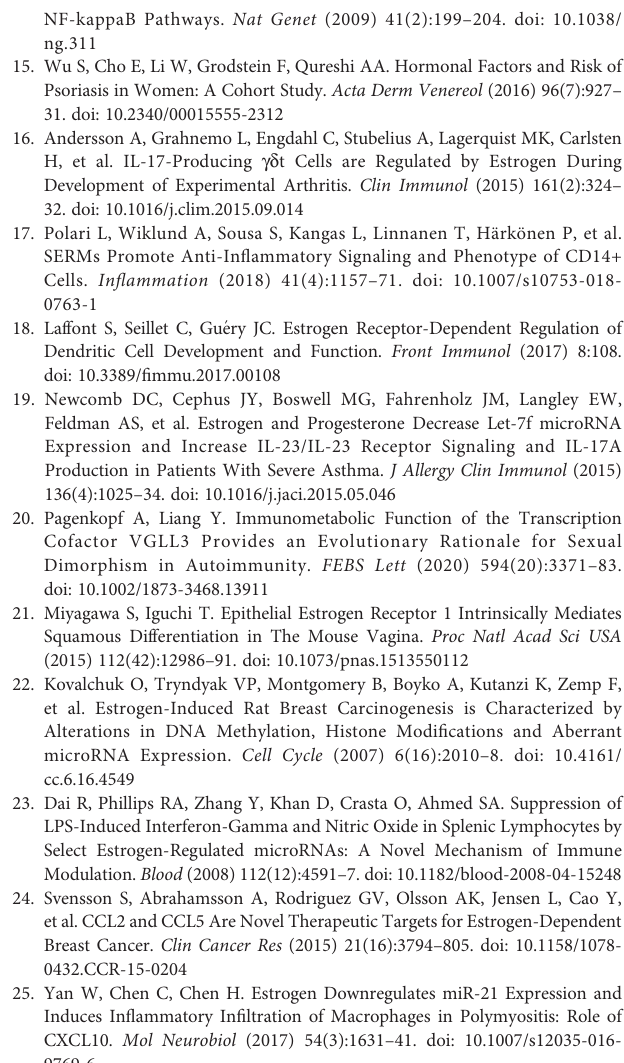
mannan (n = 5/group). Each experiment was repeated twice. Statistical analyses were performed using an unpaired t test. n indicates number of mice. The data represent mean ± SEM. * p < 0.05; ** p < 0.01. *** p < 0.001. Supplementary Figure 2 | Effect of estradiol concentration on psoriasis. PASI scores from ovariectomized BALB/c mice treated with (A) 1.0 m g, (B) 3.6 m g, or (C) 7.2 m g of 17- b -estradiol (n = 10/group). Each experiment was repeated twice. Statistical analyses were performed using an unpaired t test. n indicates number of mice. The data represent mean ± SEM. * p < 0.05; ** p < 0.01. *** p < 0.001. Supplementary Figure 3 | Gating strategy for gd + T cells and innate immune cells. (A) Gatingstrategyfor CD45 + gd + Tfromdraininglymph nodes.Gatingstrategy for innate immune cells including (B) neutrophils (CD11b + Ly6C/6G + ), (C) dendritic cells (MHCII + CD11c + ), and (D) macrophages (CD11b + F4/80 + ) from the spleen. All the immune cells were stained and detected individually. Supplementary Figure 4 | Expression of estrogen receptors in the skin. Expression of (A) ER- a , (B) ER- b , and (C) G-protein coupled receptor 30 (GPR30) in naive, male,